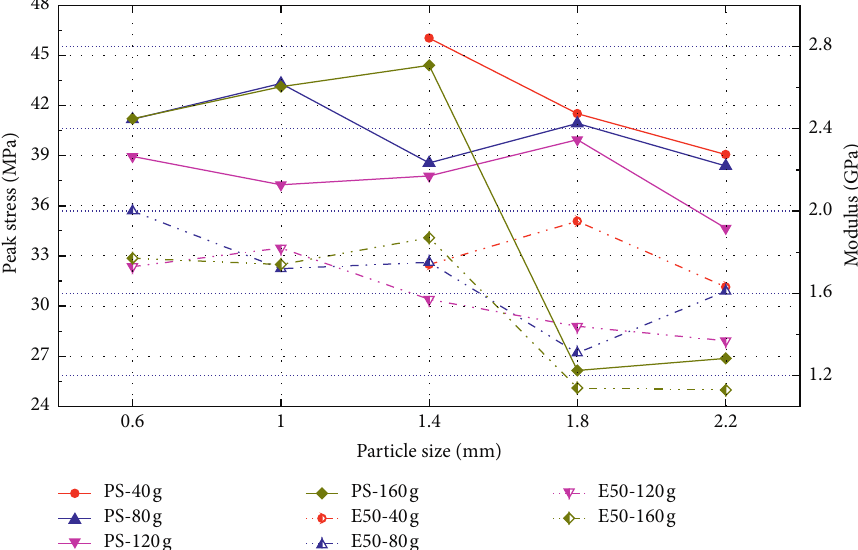
Figure 6: Relationships between the particle size and peak stress/E50 under various particle weights.